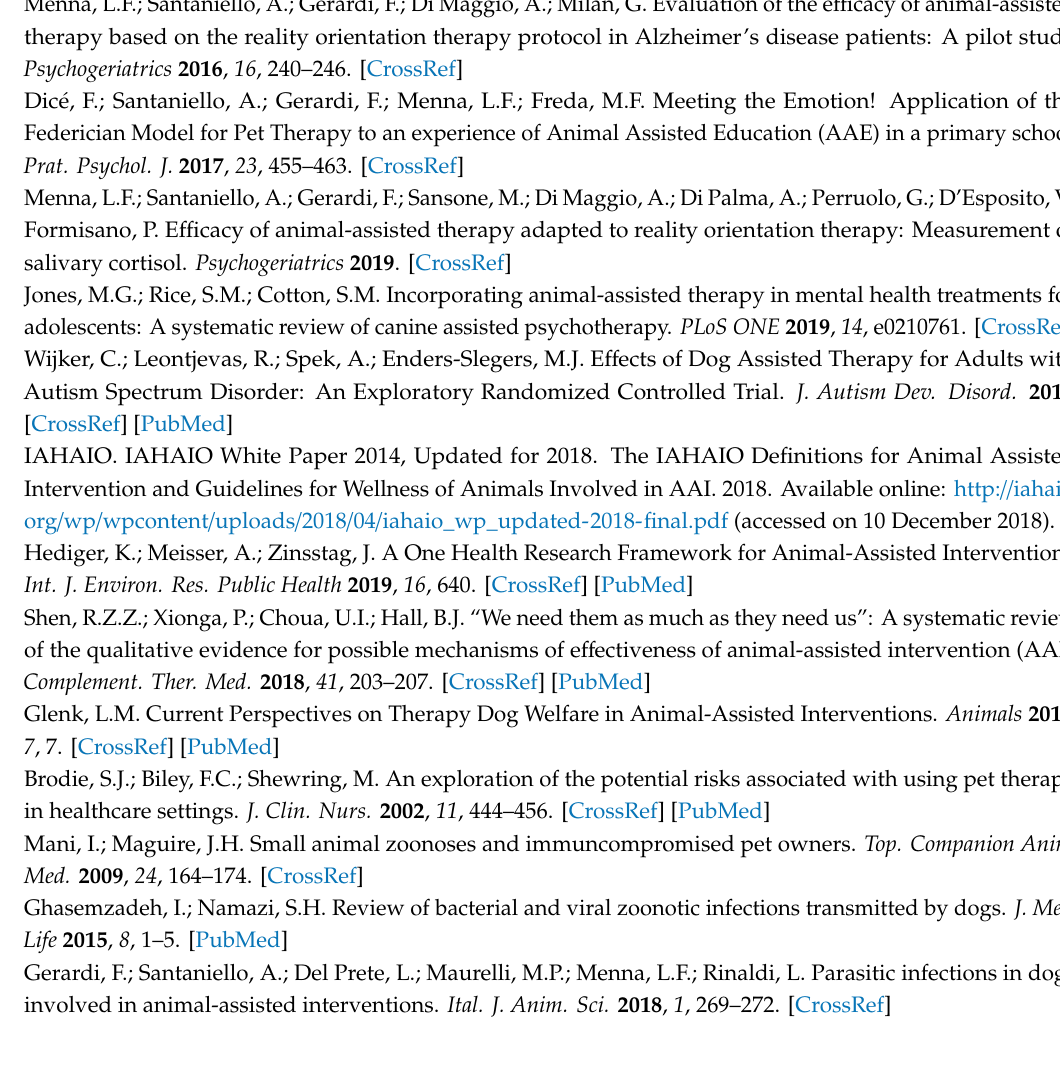
Table S1: Papers Excluded from Systematic